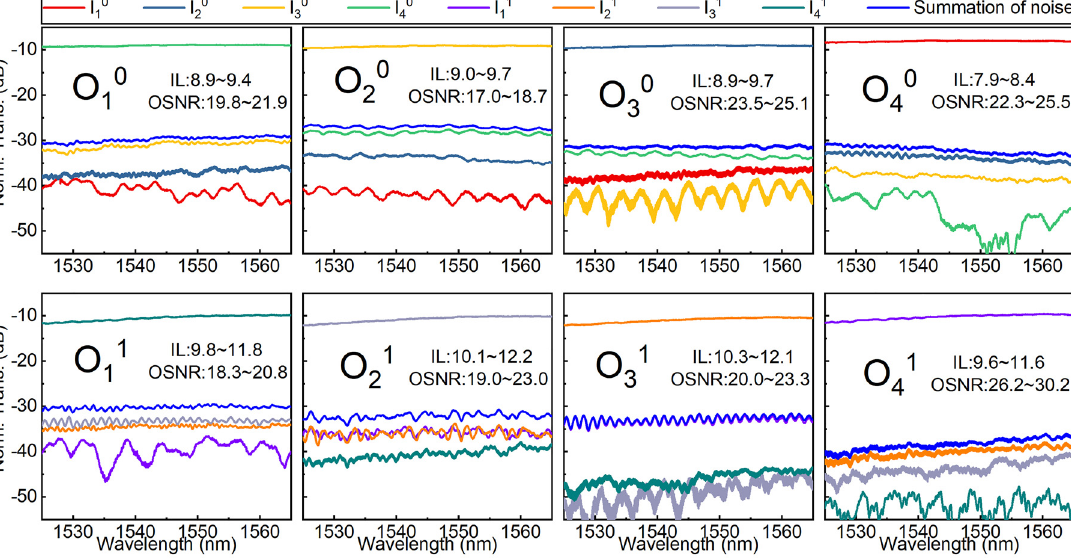
Figure 7: Normalized transmission spectra of the dual-mode 4 × 4 optical switch in the ‘‘all-cross’’